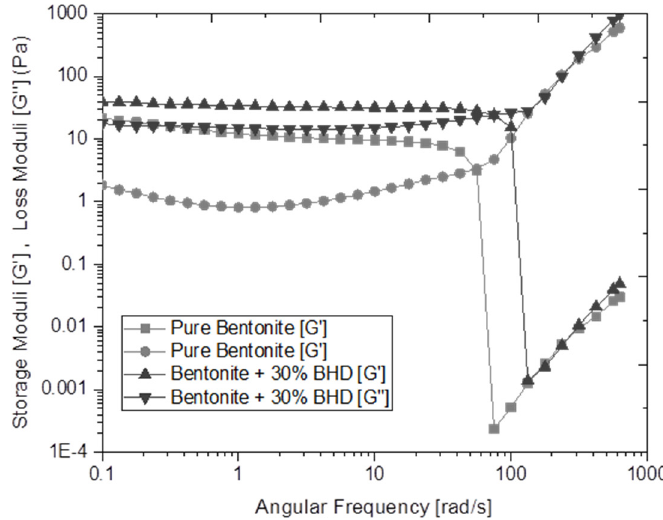
Figure 8. Dynamic flow test.